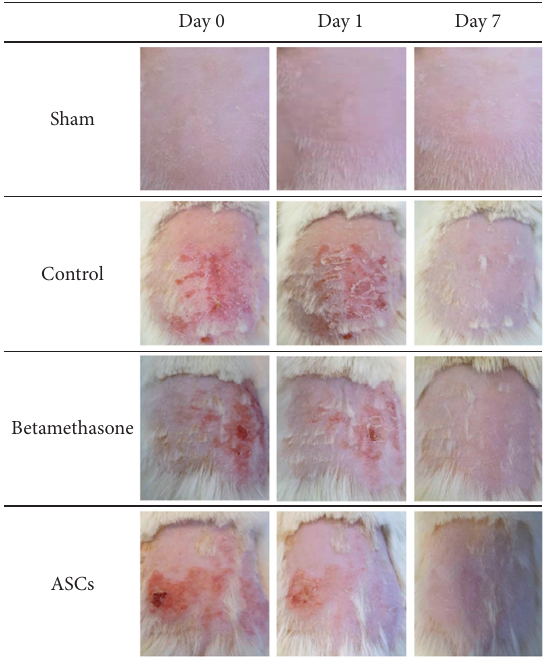
Figure 1: Macroscopic changes of rat skin in sham, control, betamethasone, and ASC groups on days 0, 1, and